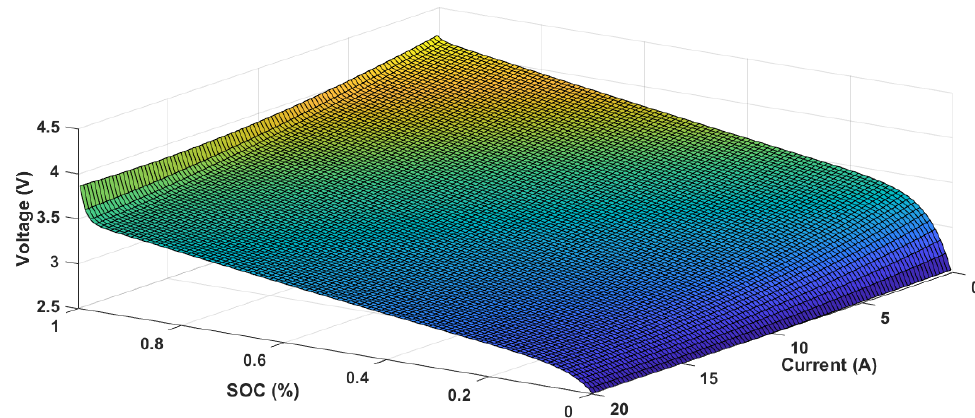
Figure 22. Data fitted by the third-degree exponential function for SoH = 100%.